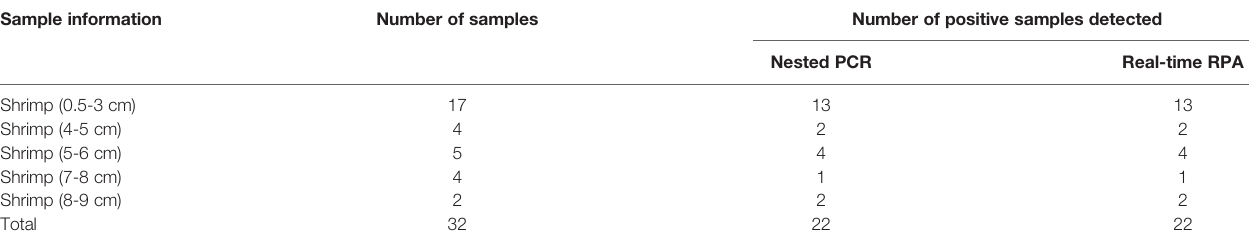
TABLE 4 | Detection of Enterocytozoon hepatopenaei (EHP) infection in clinical samples (summarized). Sample